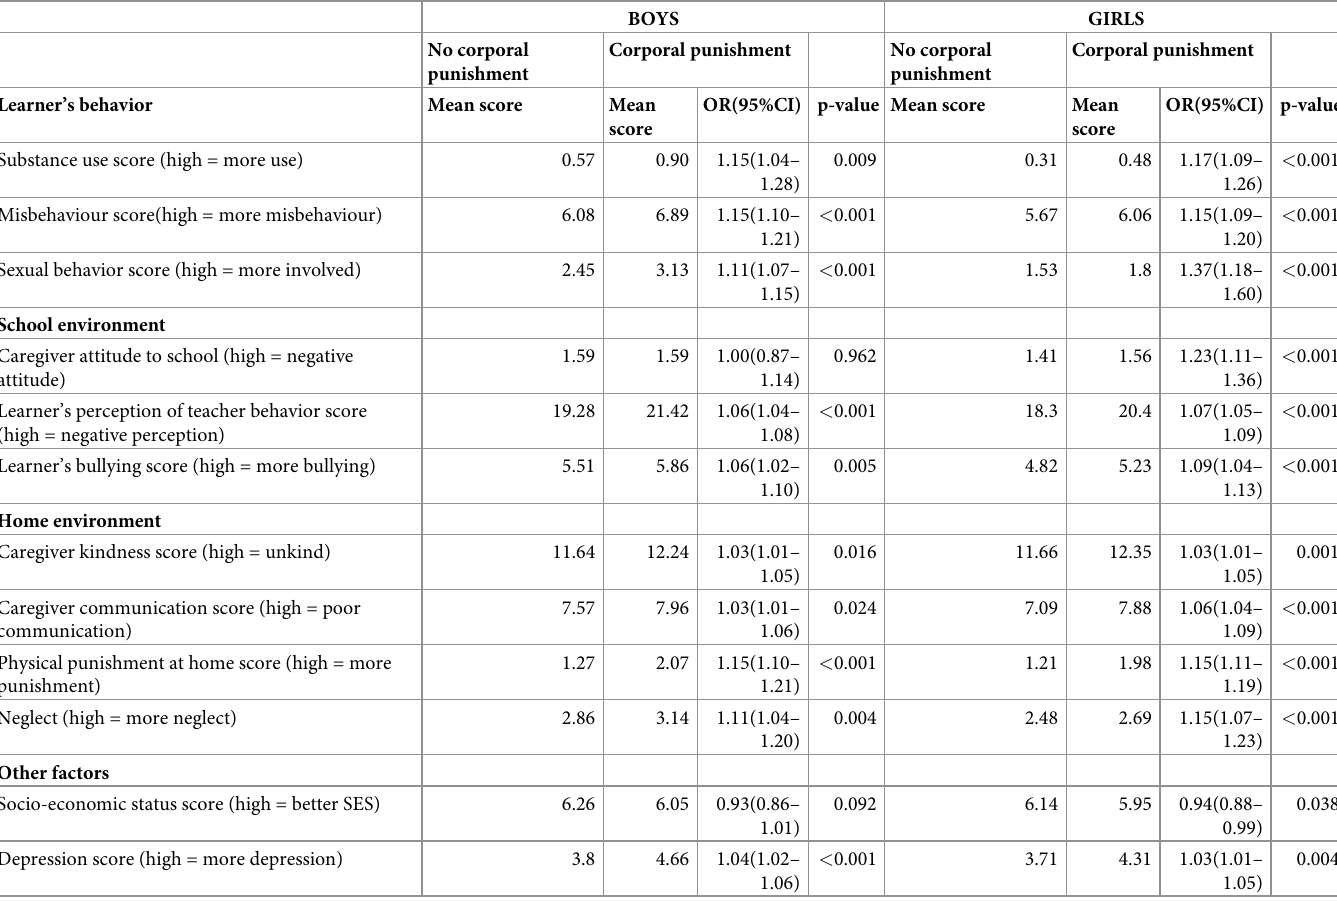
Table 3. Bivariate logistic regression of learners’ experience of corporal punishment at school and their behavior, home and school